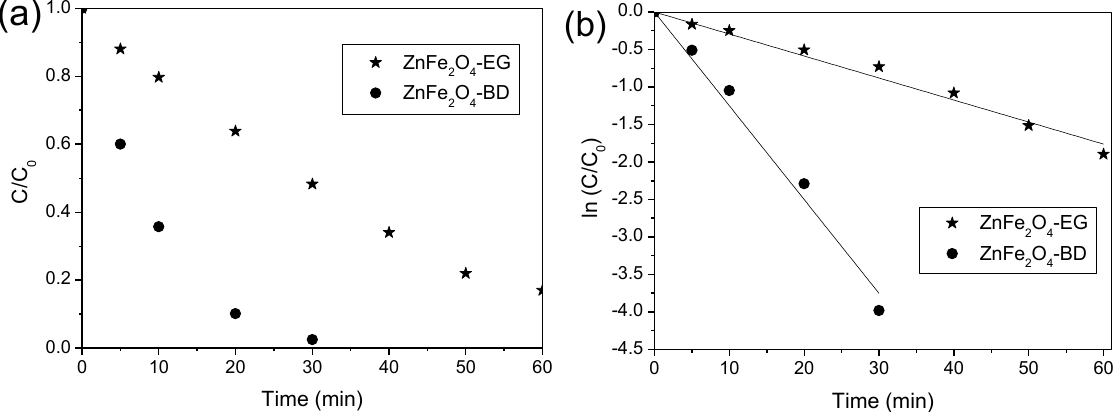
Figure 5. ( a ) Degradation profiles and ( b ) the variation of ln( C / C ZnFe O -EG and ZnFe 2 4